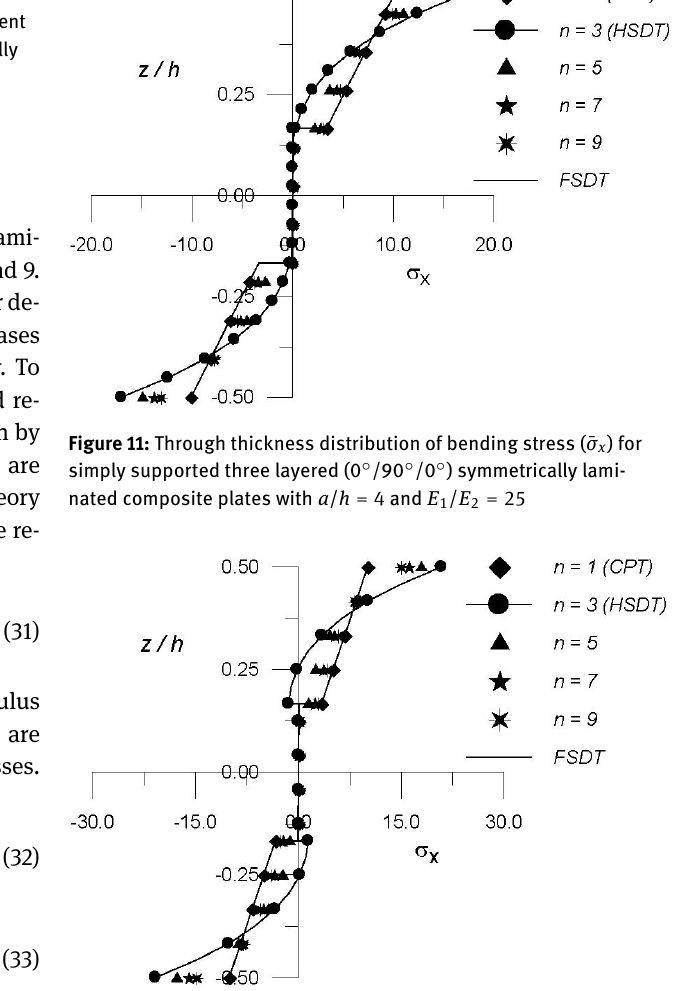
Figure 12: Through thickness distribution of bending stress ( ¯ σ x ) for simply supported three layered (0 ∘ /90 ∘ /0 ∘ ) symmetrically lami- nated composite plates with a / h = 4 and E 1 / E 2 =